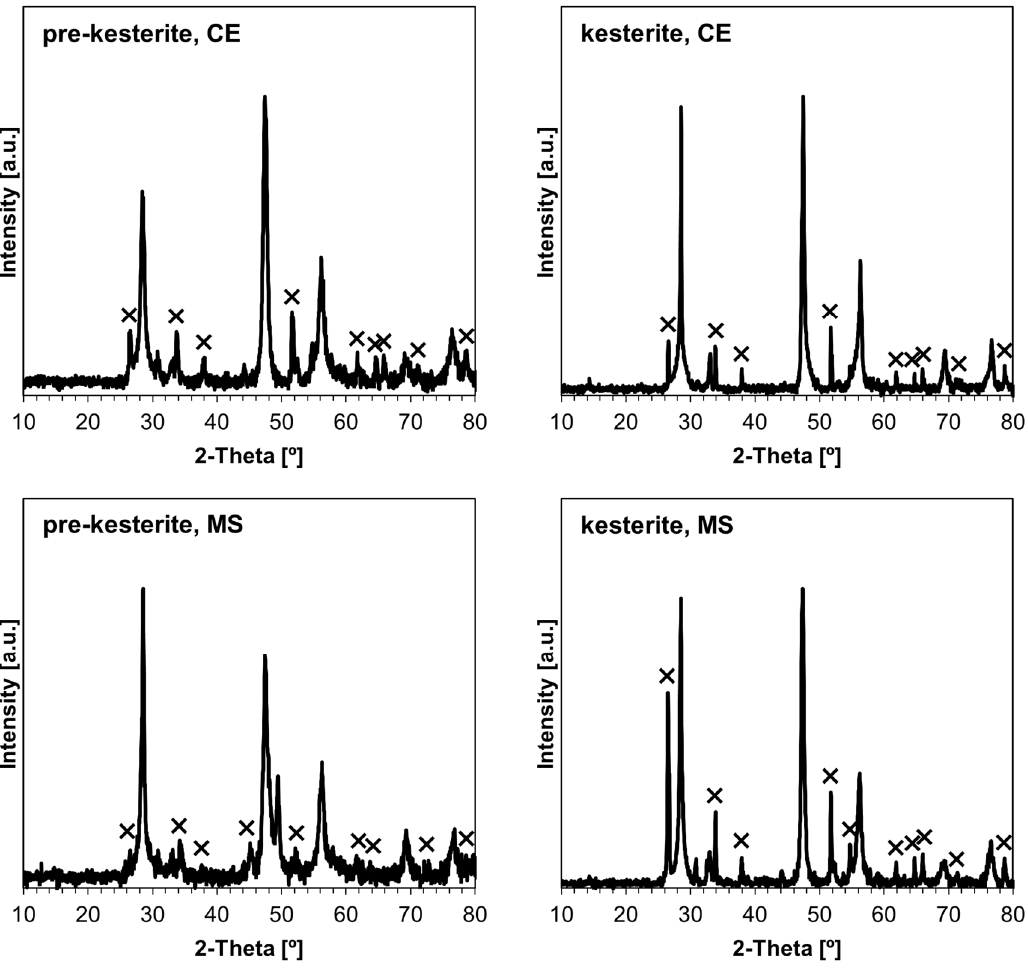
Figure 9. XRD patterns for nanoceramics prepared via the HP-HT sintering of nanopowders in the CE Figure 9. XRD pa tt erns for nanoceramics prepared via the HP-HT sintering of nanopowders in the system ( top row) and MS system ( bottom row). Symbols ( × ) are in the peak positions for cassiterite CE system ( top row) and MS system ( bo tt om row). Symbols ( ✖ ) are in the peak positions for cassit- SnO 2 , whereas the unmarked peaks are for the major cubic phase in the erite SnO 2 , whereas the unmarked peaks are for the major cubic phase in the pellets.